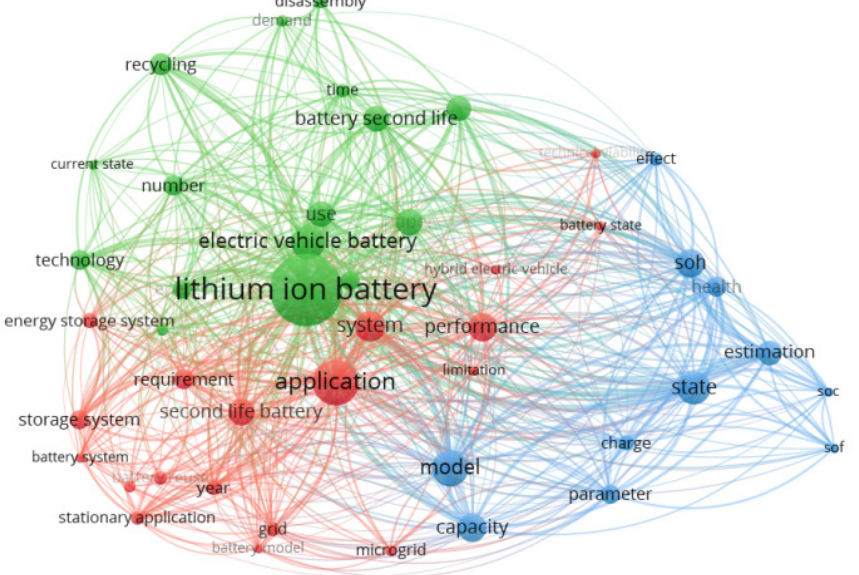
Figure 4. Cloud and word network obtained by bibliometric analysis with the software VOSViewer.